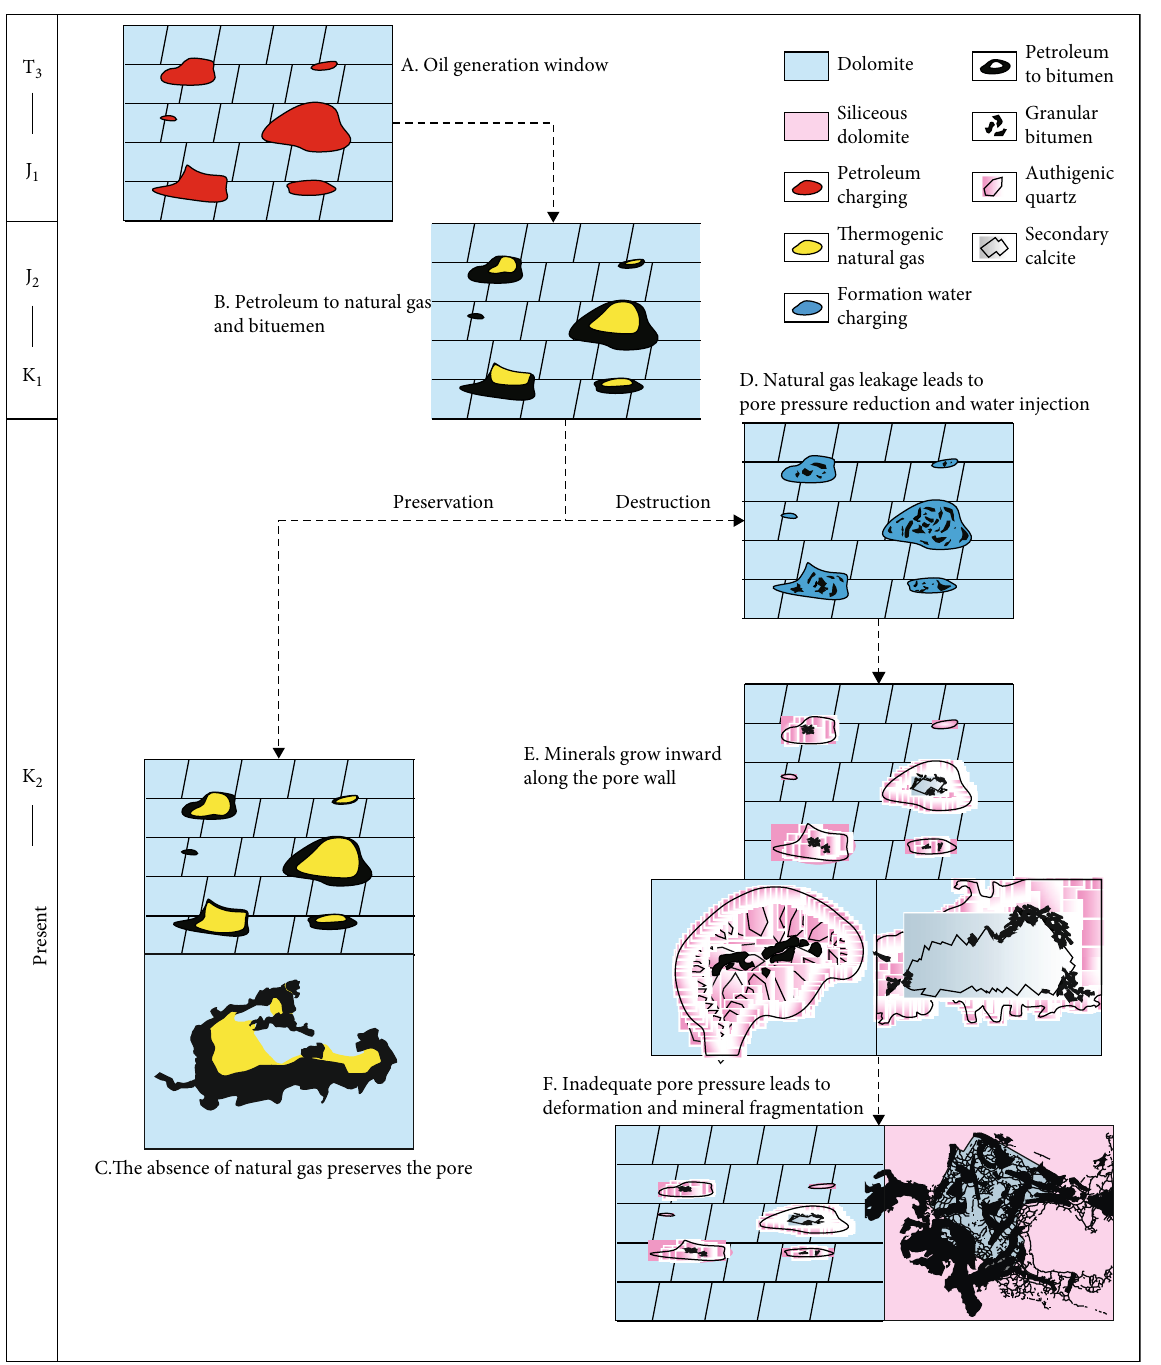
Figure 12: Di ff erential evolution of pores in the Z dn 4 member in the two wells (modi fi ed from [25]). Annular-shaped bitumen with 2 dn 4 reservoir is widespread in CS well #1, which is attributed to continuous preservation of the CS contraction joints in pores of the Z 2 well #1 palaeo-gas reservoir. In contrast, broken granular bitumen is scattered in pores with authigenic quartz in MS well #1, indicating signi fi cant destruction and dissipation of the palaeo-gas fi eld in MS well